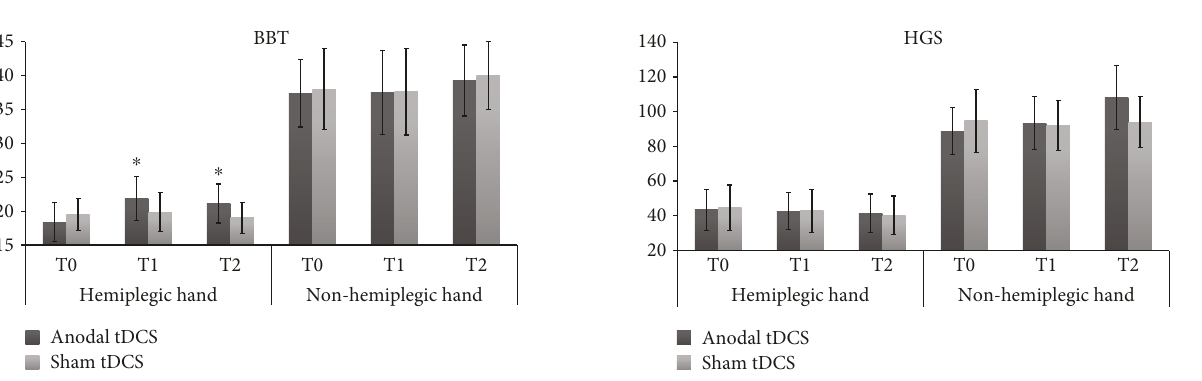
Figure 2: BBT scores (i.e., number of blocks moved in 1 min) for the hemiplegic and nonhemiplegic hands, at each assessment of the active anodal tDCS and sham tDCS sessions. T0 =baseline; T1 =immediately after the end of tDCS; T2 =90 min after the stimulation session. ∗ =signi fi cant change from baseline, p < 0 05 .